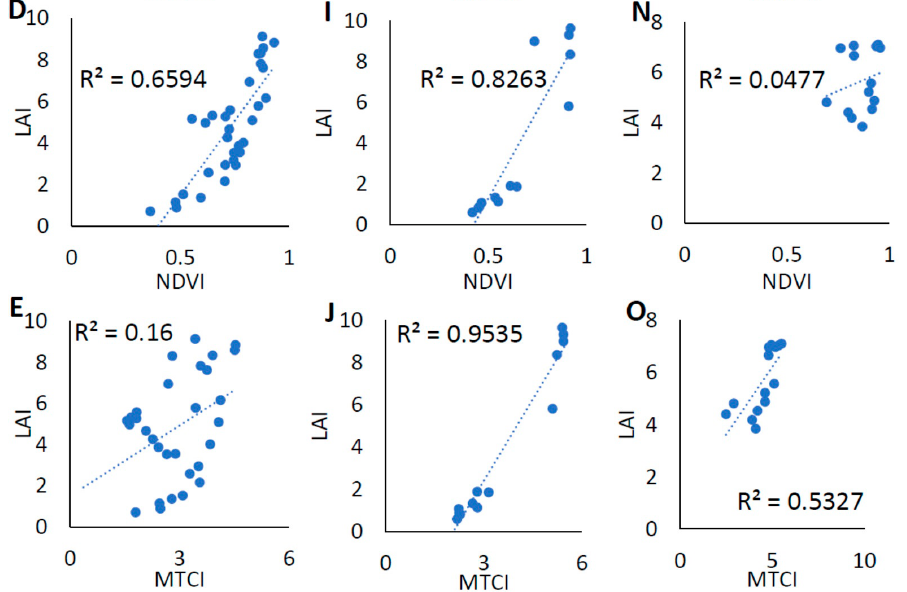
Figure 5. Tomato, cotton, and wheat LAI-VI linear regression models: ( A ) Tomato reNDVI; ( B )